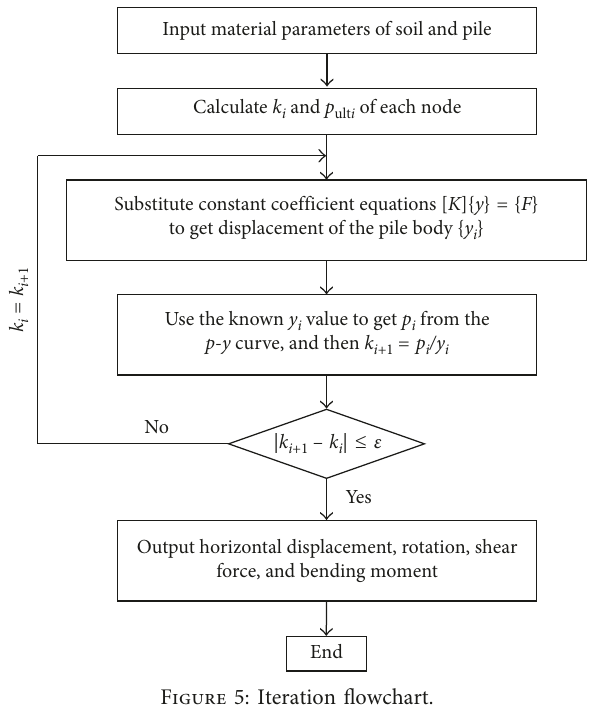
Figure 5: Iteration flowchart.